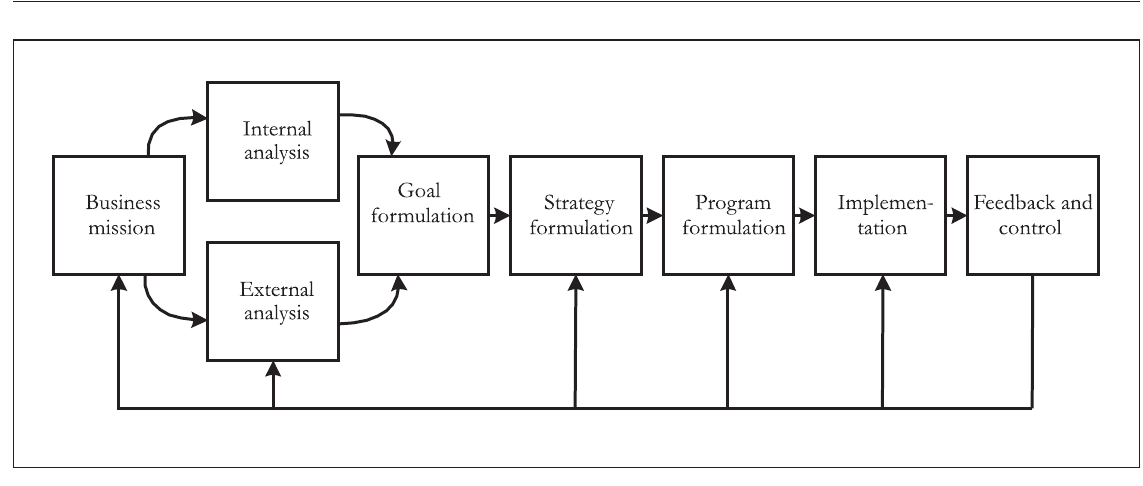
Figure 1. Model of the strategic business planning process